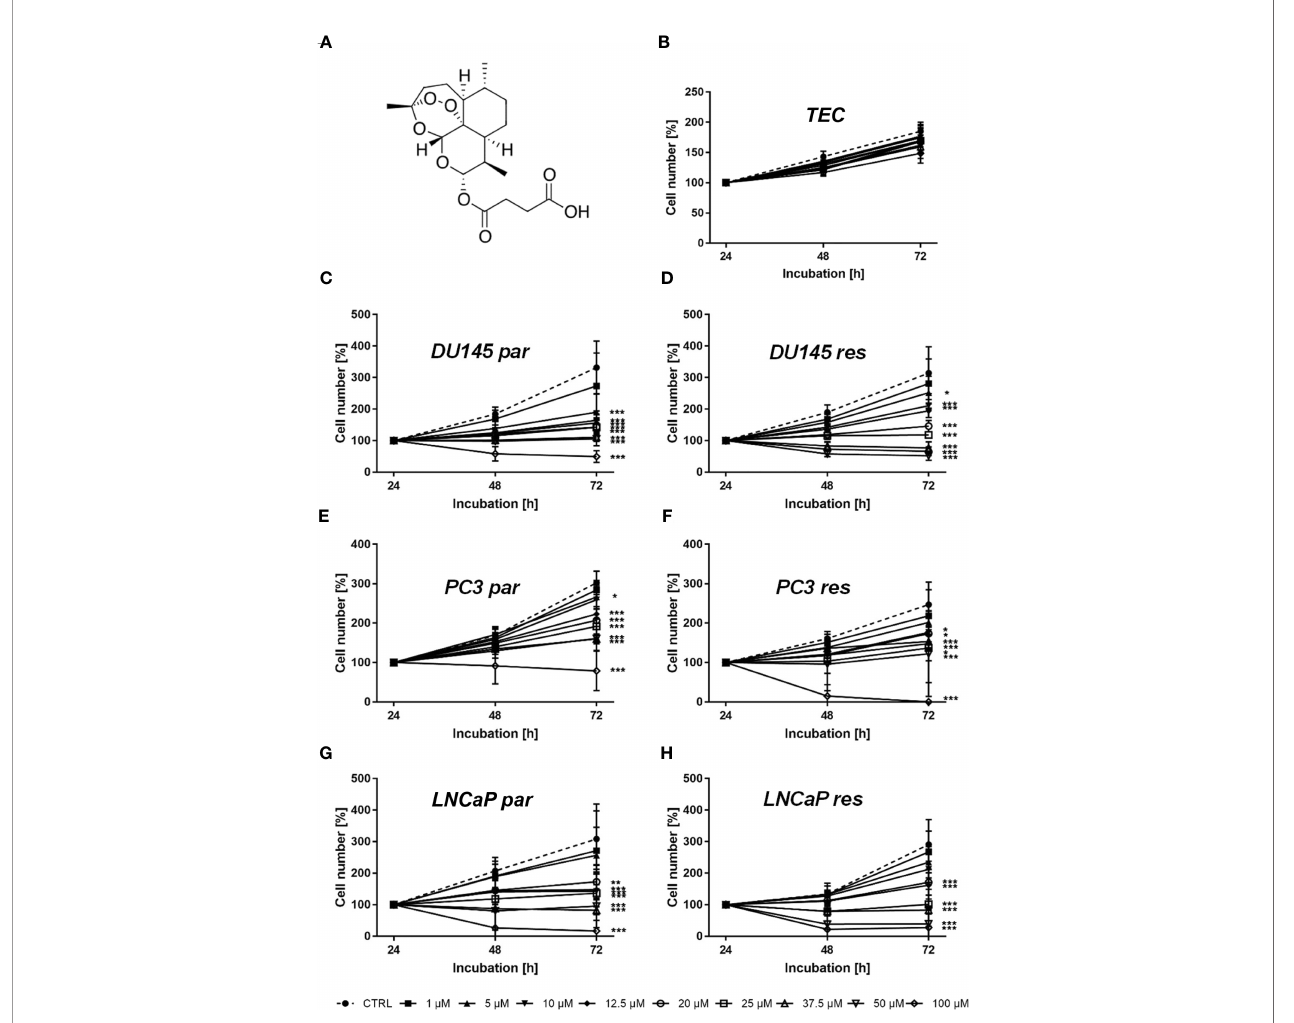
FIGURE 1 | Chemical structure of ART (A) and cell growth of normal (healthy) TEC cells (B) as well asof parental (par) and DX-resistant (res) DU145 (C, D) , PC3 (E, F) , and LNCaP (G, H) PCa cells after 24, 48, and 72 h incubation with ART concentrations ascending from 1 – 100 µM. Untreated cells served as controls. Cell number was set to 100% after 24 h incubation. Error bars indicate standard deviation (SD). Signi fi cant difference to untreated control: *p ≤ .05, **p ≤ .01, ***p ≤ .001. n =